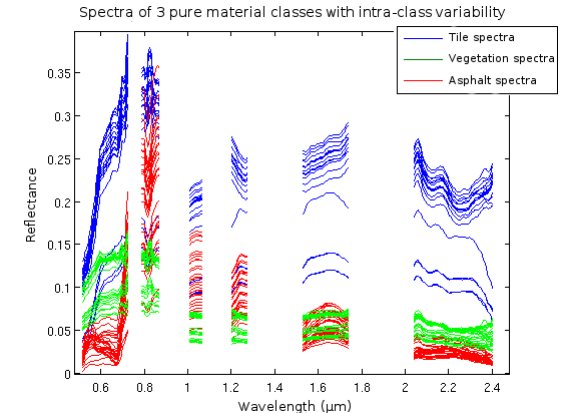
Figure 1. Spectra of three different classes of materials: vegetation (red), tile (blue), asphalt